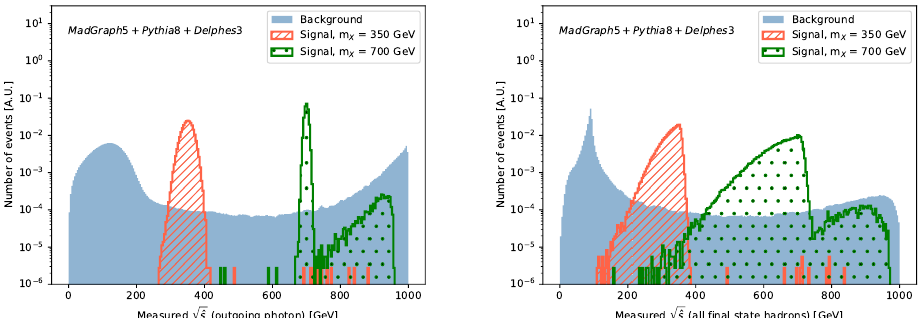
√ ˆ s when the outgoing photon is captured and